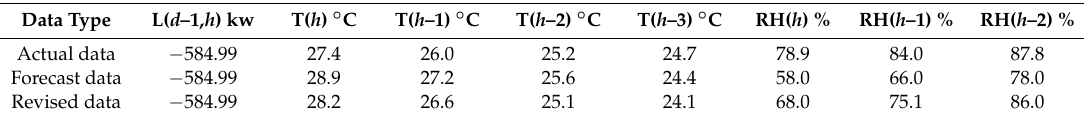
Table 3. The input parameters of the load forecasting model.